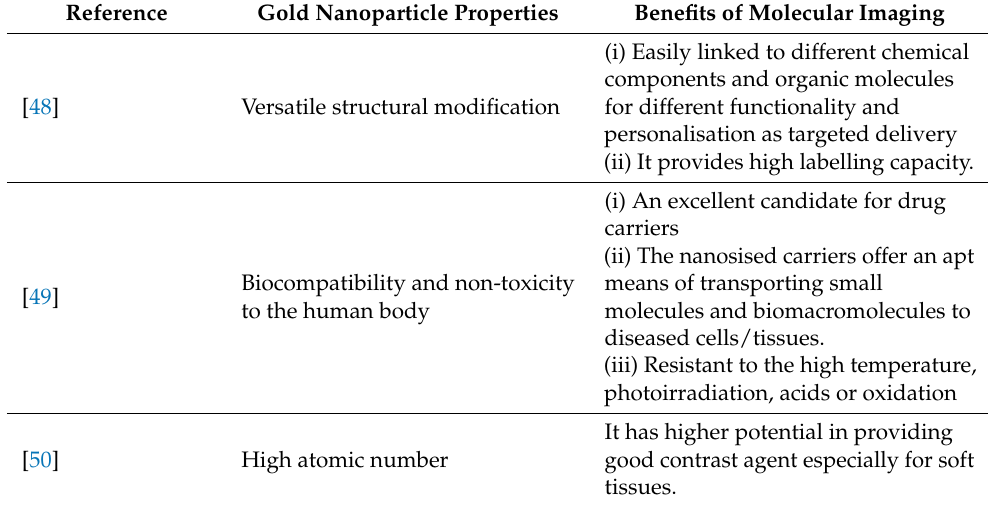
Table 6. The gold nanoparticle properties and the benefits of molecular